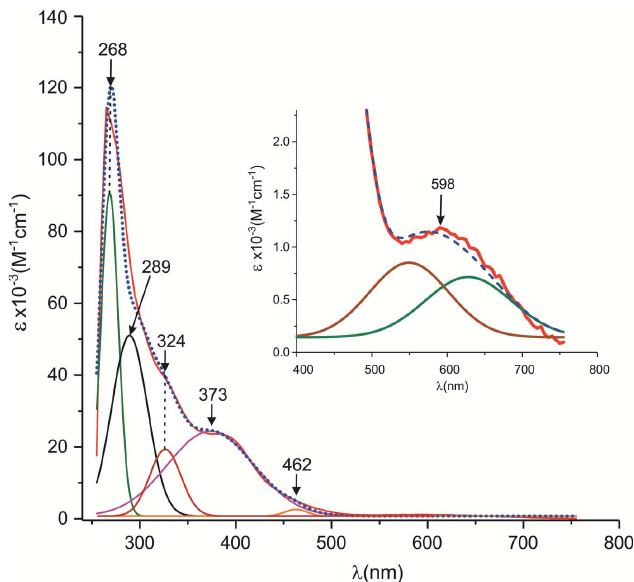
Figure 4 UV–vis spectrum of the title polymorph dissolved in DMSO. The experimental spectrum (red line) is fitted with Gaussian functions for which maxima are indicated. The sum of these Gaussian functions affords the theoretical spectrum (dotted blue line). The visible range of the spectrum is displayed in the inset, using a scale allowing the d – d transitions to be assessed, fitted with two Gaussian functions, giving a maximum at (cid:6) = 598 nm.